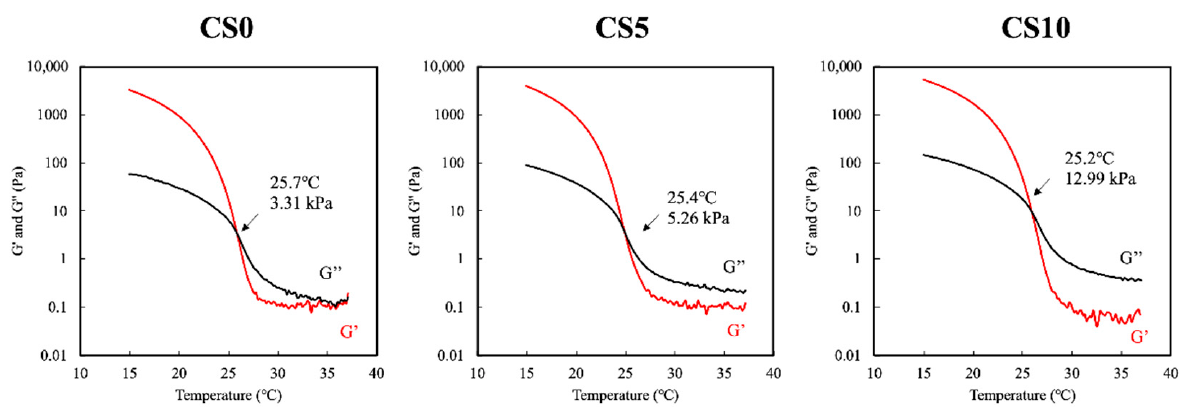
Figure 3. Rheological analyses of CS0, CS5 and CS10. The intersection between storage modulus G ′ and loss modulus G ″ was regarded as the sol–gel transition temperature.